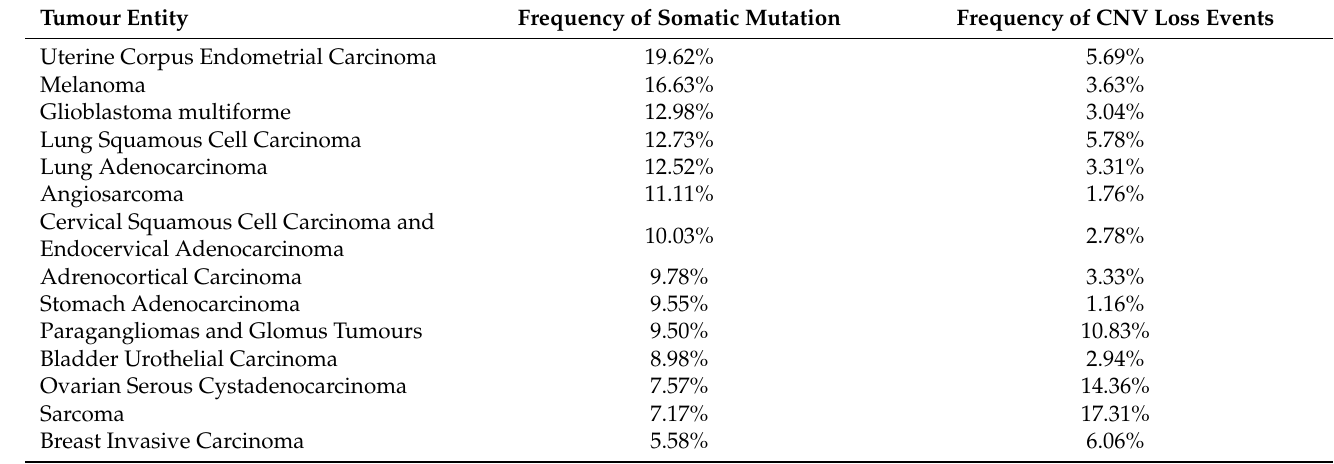
Table 1. Loss of NF1 in a spectrum of neoplasms underlines its tumour suppressor function (mutation frequencies of NF1 according to the Genomic Data Commons Data